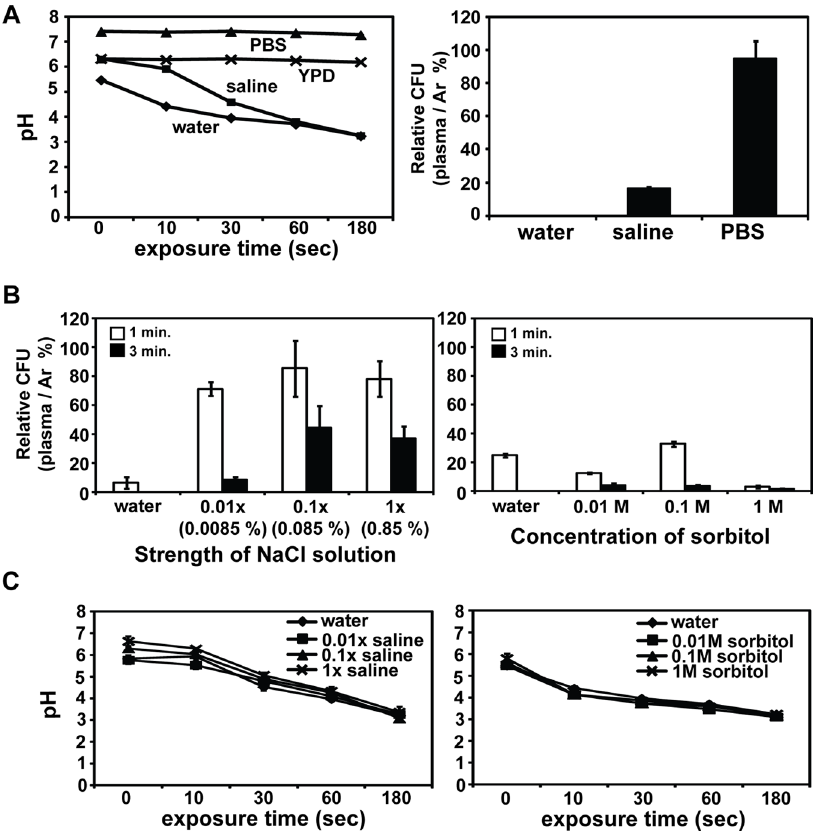
Figure 5. pH change after plasma treatment and effects of osmotic strength of background solutions. ( A ) pH of water, saline, PBS, and YPD after plasma treatment (left panel) and the effect of PBS on yeast cell viability (right panel). For pH measurements, 1 ml of each solution was exposed to plasma for the indicated time. The effect of PBS was assessed by measuring relative viability of plasma-treated cells compared to that of Ar gas-treated cells. Cells were treated with plasma for 3 min. ( B ) Viability of yeast cells in different concentrations of NaCl (left panel) and sorbitol (right panel) after plasma treatment. Yeast cells were treated with Ar gas and plasma for 1 and 3 min. ( C ) Changes in pH of NaCl (left panel) and sorbitol (right panel) solutions during plasma treatment. One ml of saline and sorbitol was exposed to plasma at the indicated concentrations for 10, 30, 60, and 180 sec. In (A) and (B), cell viability was assessed by relative ratio in colony forming units (CFU) calculated as follows: relative CFU (%)=(CFU number of plasma treated yeast/CFU number of Ar gas treated yeast) 6 100. All values are the average of three technical